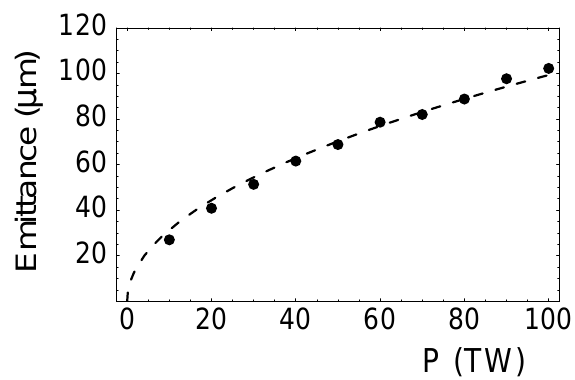
FIG. 11. Normalized transverse emittance after 2.7 mm accel- eration for different bunches (see text), as a function of peak power. Dots are simulation results; the dashed line is a P 1 (cid:3) 2 fit.